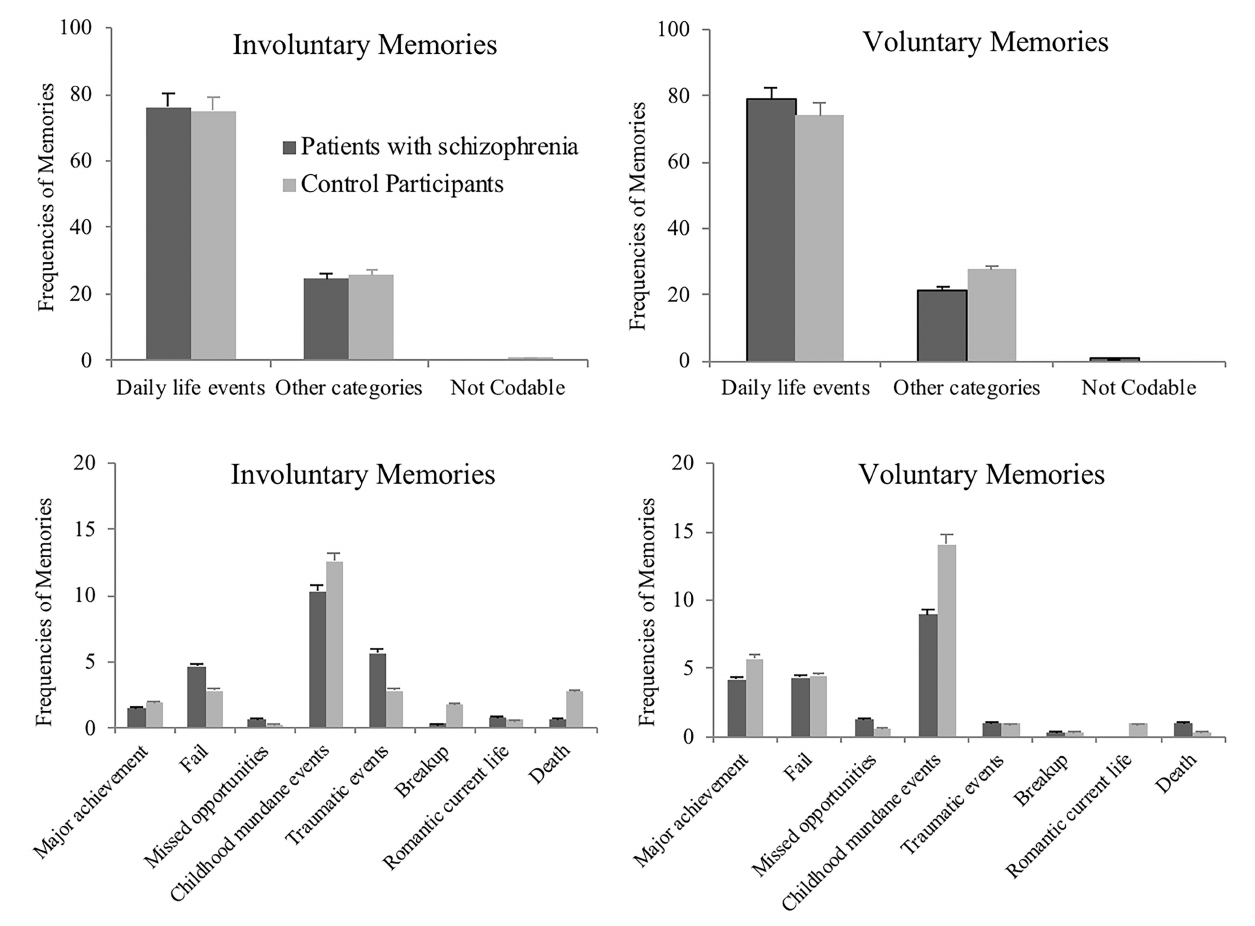
FIGURE 2 | The upper plots show the frequencies of involuntary and voluntary autobiographical memories related to mundane daily life events or other categories of event, in patients with schizophrenia and in control participants, in Study 1. The lower plots show the distribution of these other categories of event, across groups and separately for involuntary and voluntary memories, in Study 1. Error bars represent standard